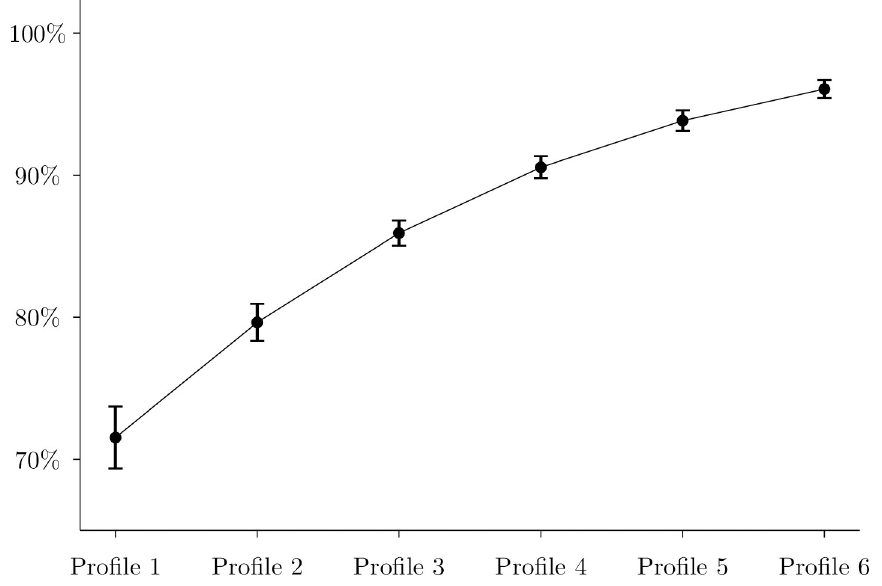
Fig 4. Marginal effects for g = 5. Notes . The estimated marginal effects and confidence intervals correspond to the logit model presented in Table 5 for the case g =